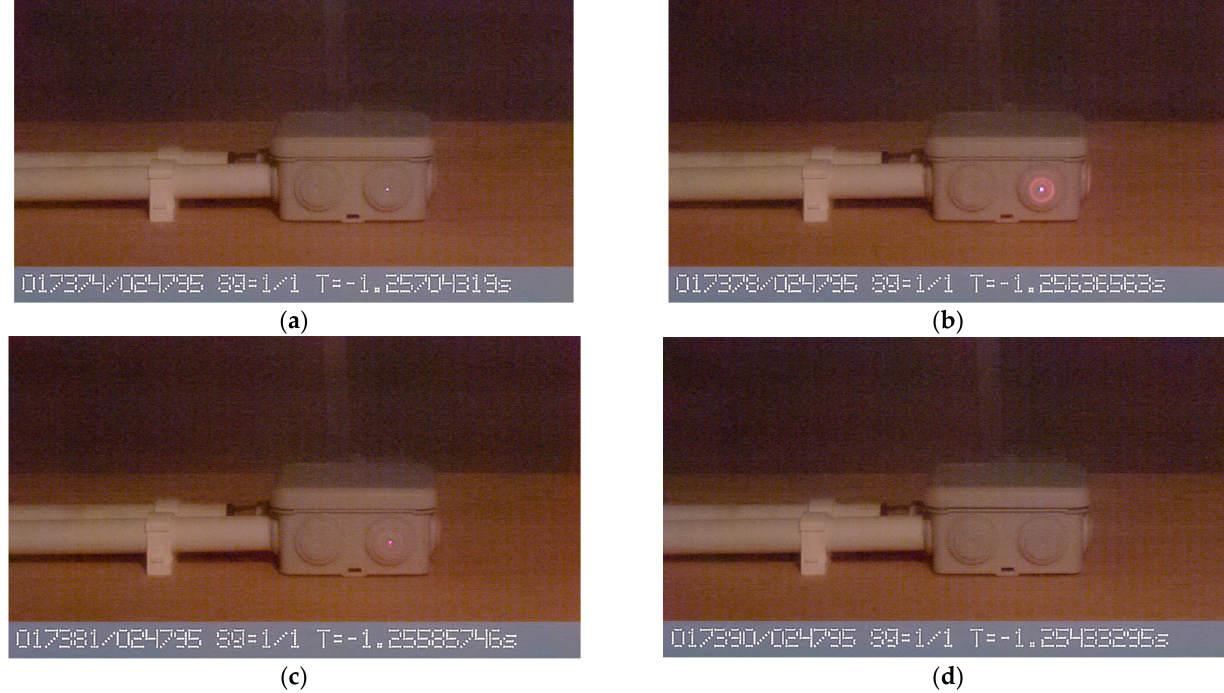
Figure 13. Images of the state of the installation box during an arc fault in a system equipped with an MSAE emergency arc eliminator: ( a ) t 1 = 0 ms electrcial arc initiation phase, ( b ) t 3 = 0.69 ms beginning of conduction through MSAE, ( c ) t 4 = 0.9 ms full conduction by MSAE, ( d ) t = 2.65 ms electrcial arc extinction phase ( I m = 1300 A, U = 230 V, Cu-Cu electrodes).